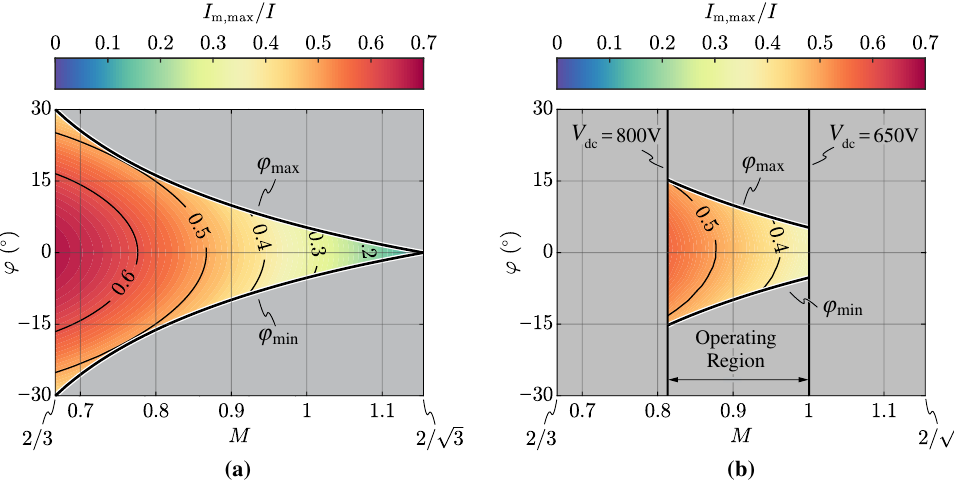
Figure 8. Mid-point current periodical average limits I m,max = − I m,min (i.e., normalized with respect √ to the peak phase current I ) for 2 / 3 ≤ M ≤ 2 / 3 . ( a ) analytical results and ( b ) experimental results, limited to the operating region of the rectifier prototype (see Section